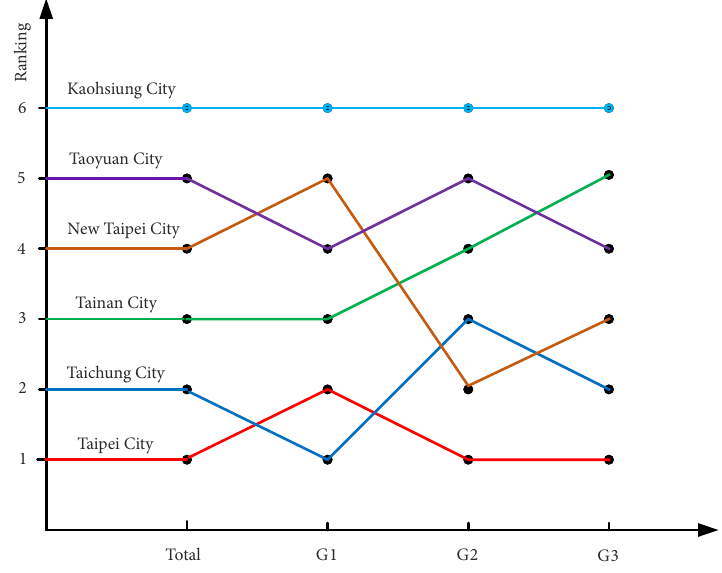
Figure 3. Ranking of the six cities for different groups in total aspects